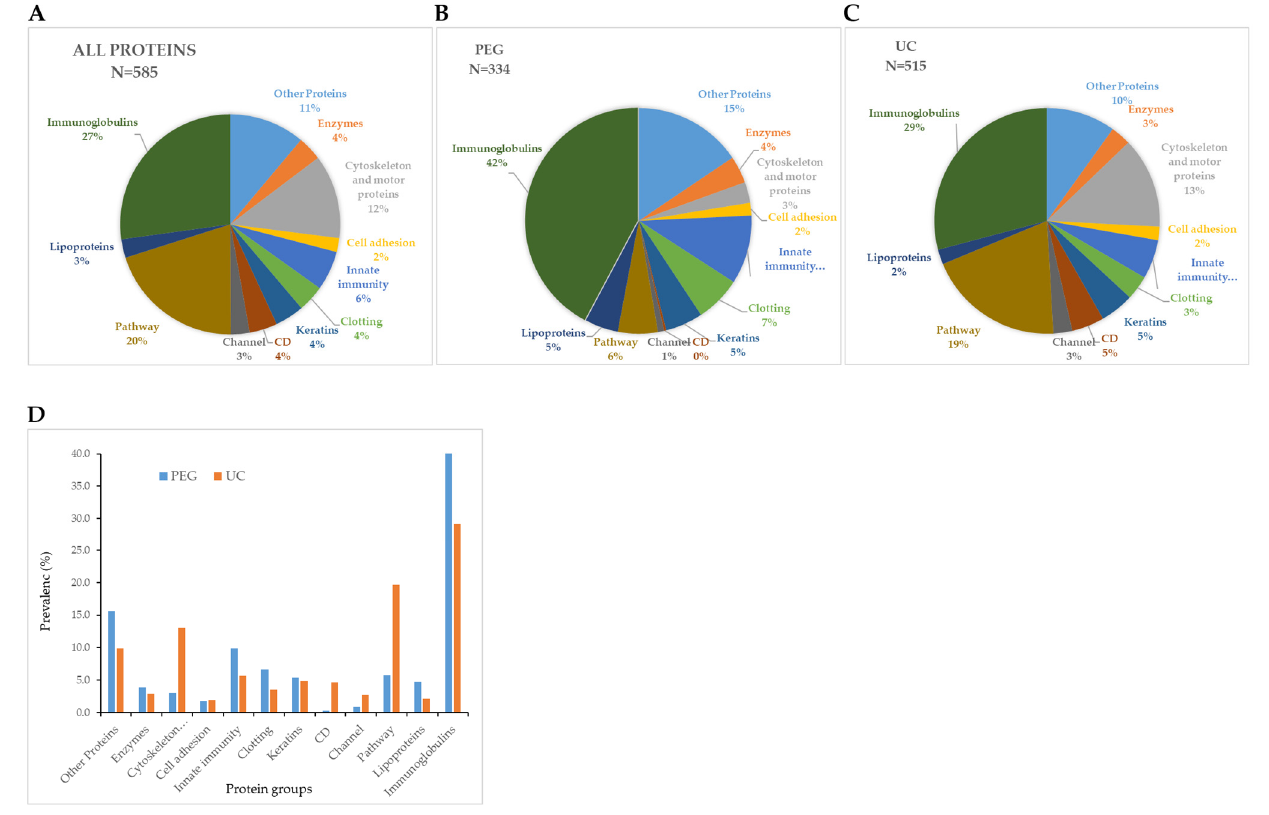
Figure 2. Proteomic analysis of EVs. ( A ) In total, 585 unique proteins were found from EVs purified with ultracentrifugation (UC) and polymer precipitation (PEG). These 585 proteins were divided into 12 groups and are represented here as the prevalence of the protein group. ( B ) The prevalence of protein groups identified from EVs purified by PEG precipitation. ( C ) The prevalence of protein groups identified from EVs purified by ultracentrifugation. ( D ) Comparison of the prevalence of proteins purified by PEG precipitation and ultracentrifugation.